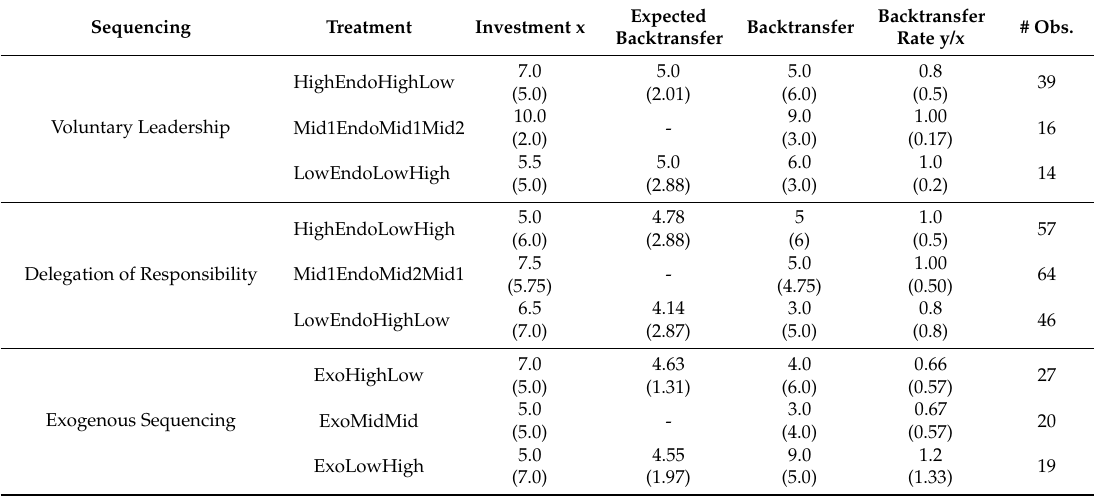
Table 3. Summary Statistics: Median (Interquartile Range).